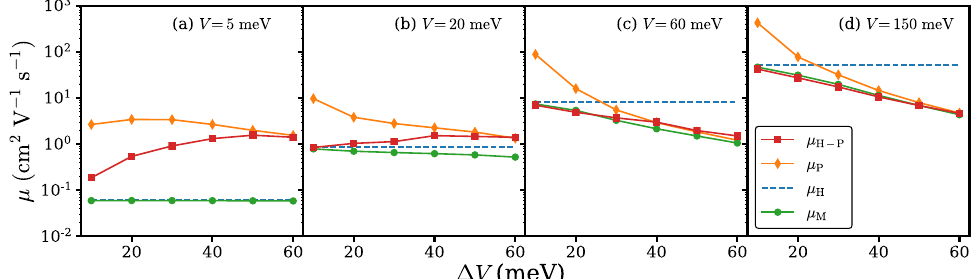
Fig. 3 Carrier mobility at 300 K calculated based on the Holstein – Peierls model ( μ H-P ), Holstein model ( μ H ), Peierls model ( μ P ), and Matthiessen ’ s rule ( μ M ) with enlarged local EPC at various transfer integral V and transfer integral fl uctuation Δ V . From a – d the transfer integrals are 5, 20, 60, and 150 meV respectively.